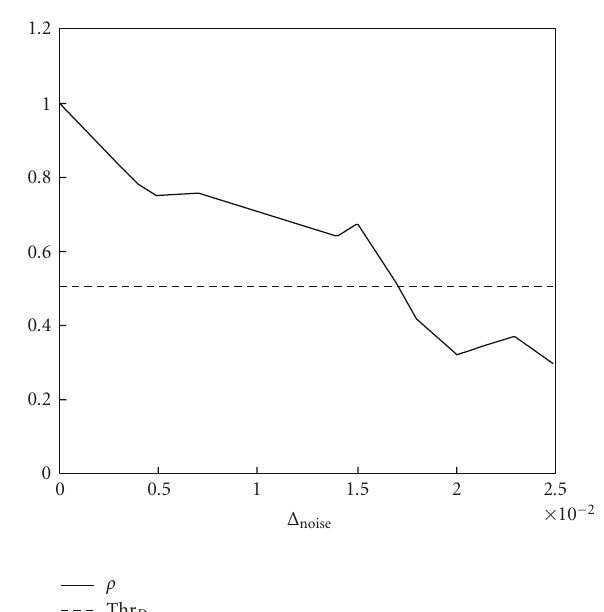
Figure 3: (a–c) add noise.